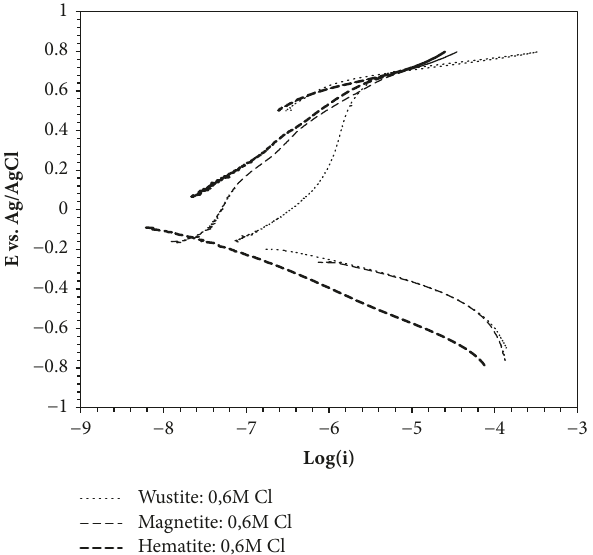
Figure 6: Anodic and cathodic potentiodynamic polarization curves for a steel exposed in a saturated Ca(OH) 2 solution and a steel sample in saturated Ca(OH) 2 solution with 0.6 M Cl − .